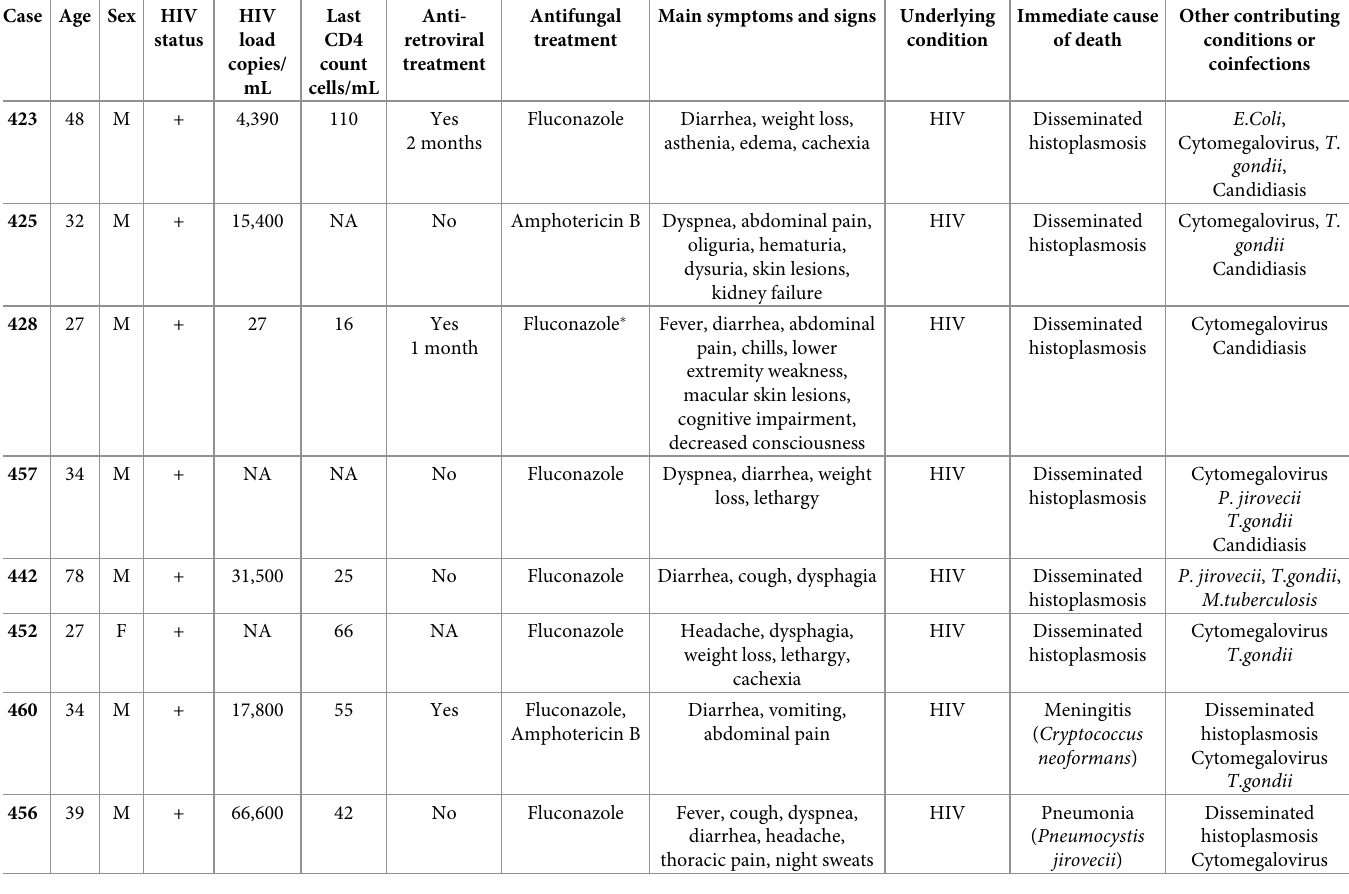
37), and significantly contributed to death in 22% (8/37) of HIV-positive patients. Clinical characteristics of the patients with disseminated histoplasmosis The demographic characteristics, HIV status, HIV viral load, pre-mortem CD4 cell counts, antiretroviral and antifungal treatment, clinical signs and symptoms, and the final cause of death of the eight disseminated histoplasmosis are summarized in Table 1. The median age of these patients was 39.8 years (range 27–78 years) and 7/8 cases were males. Only three patients were receiving antiretroviral therapy. The HIV infection was suspected in all eight cases during hospitalization, but could be confirmed during life only in six patients. The last CD4 count Table 1. Demographical, clinical characteristics and antifungal treatment of the eight patients with disseminated histoplasmosis. Case Age Sex HIV